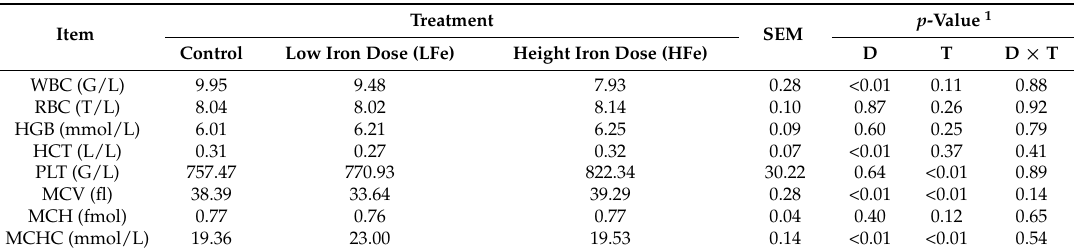
Table 1. Mean values of hematological parameters in calf blood.